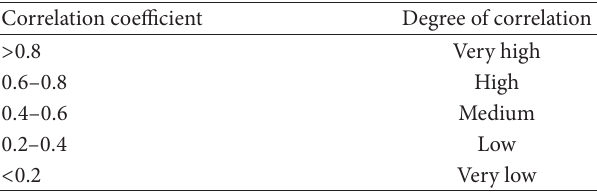
Table 6: Pearson correlation